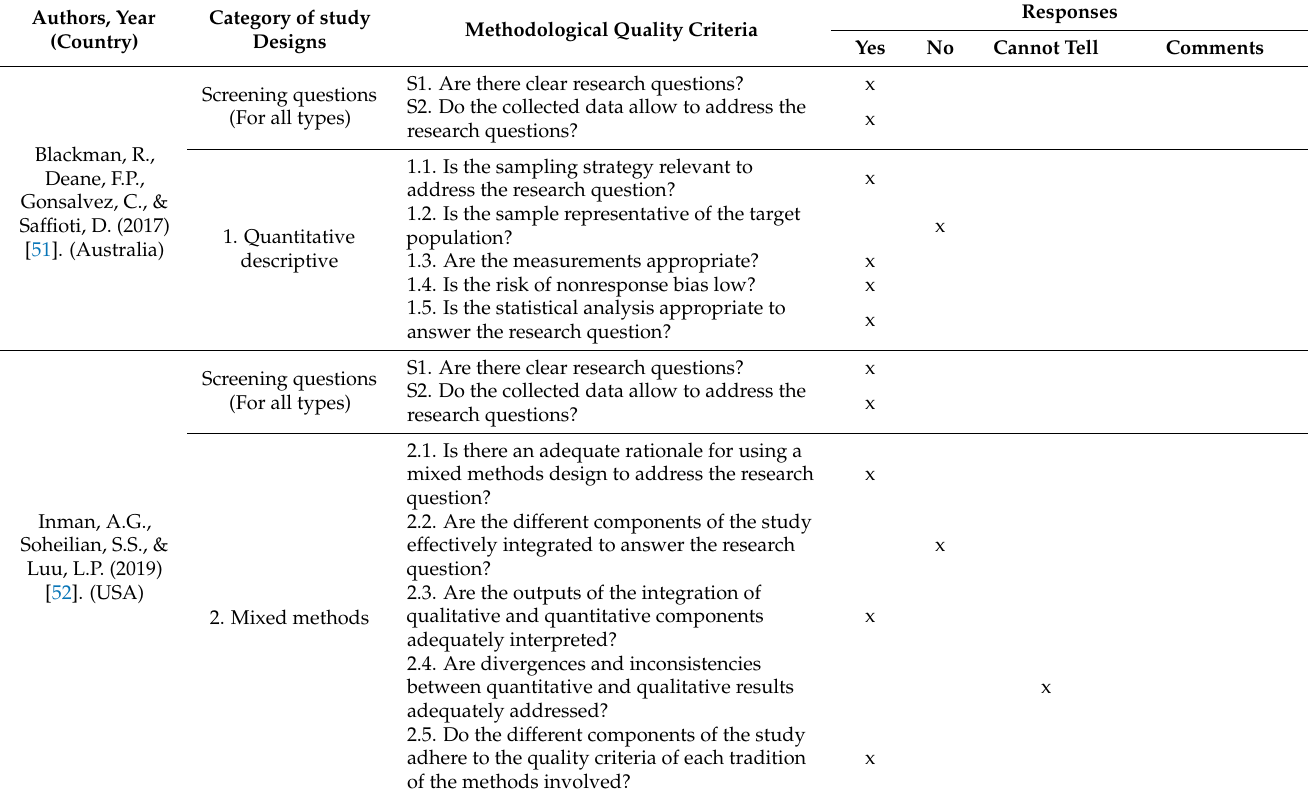
Table 4. Quality assessment of the selected